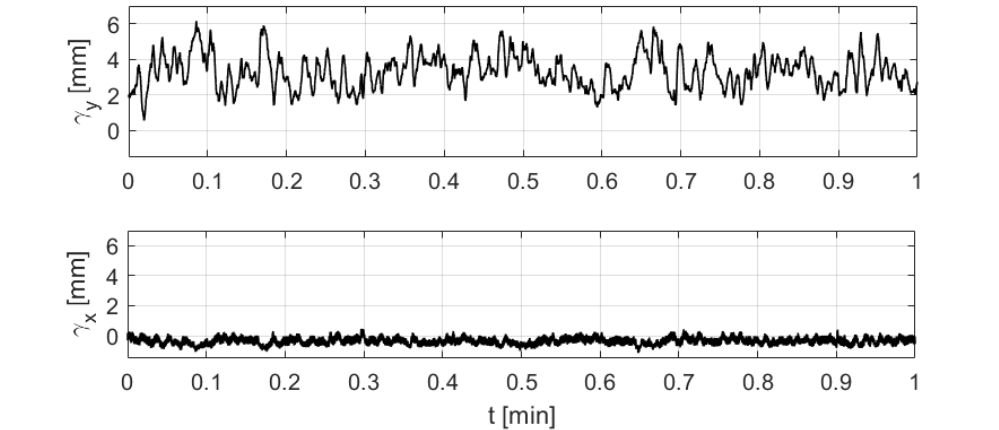
Figure 5. Wake-induced deflection values of a sample whisker in both x ( bottom ) and y ( top )